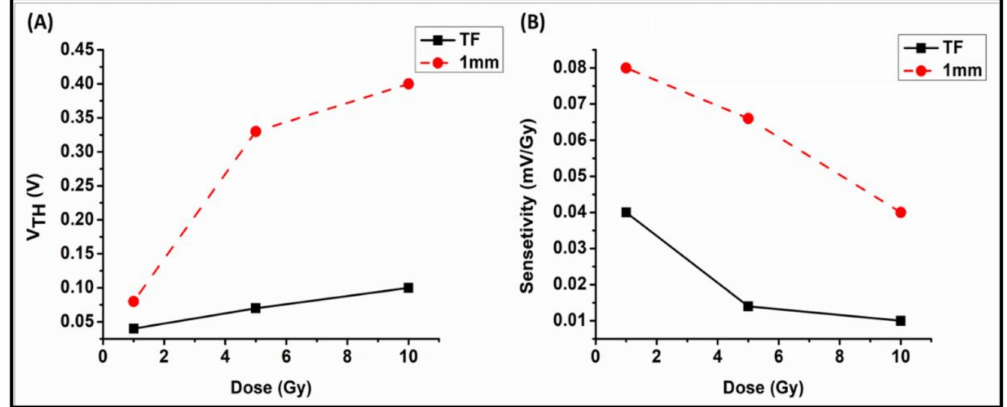
Figure 9. ( A ) Threshold voltage vs. dose and ( B ) sensitivity vs. dose for the ZnO-Pb thin film and the disk irradiated with high dose. Table 3. Radiation sensing characteristics of ZnO-Pb under high radiation doses and various thicknesses. Sensitivity Absorbed Dose Threshold Voltage Sample Linearity (%) (Gy) (mV) (mV/Gy) ( µ A/Gy) 1 0.04 0.04 5.805 0.07 0.014 90.4 TF ZnO-Pb 10 0.1 0.01 0.08 0.08 96.8 0.066 0.4